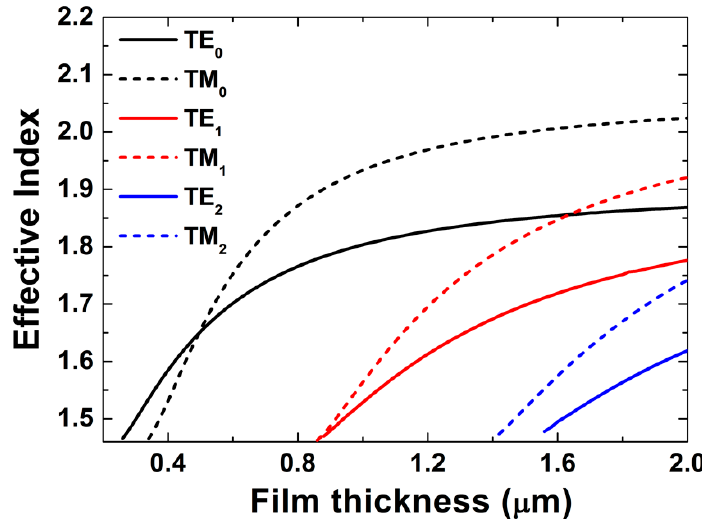
Figure 2. Effective index of the TE (solid lines) and TM (dashed lines) modes in LN waveguides as a function of the film thickness for a waveguide with 0.7 μ m width; the modes were calculated at λ = 1.55 μ m.